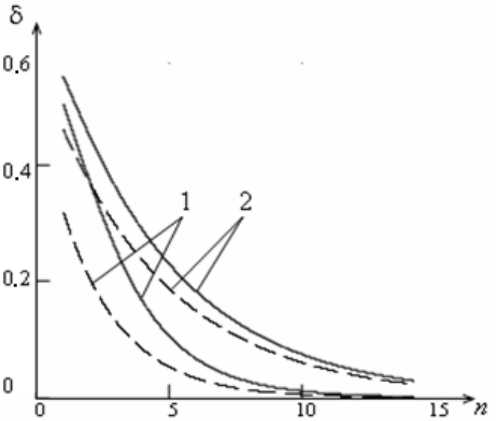
20 of 32 Table 4. Results with new weight coefficients, as well as using new approximation methods. Air Excess Factor, α